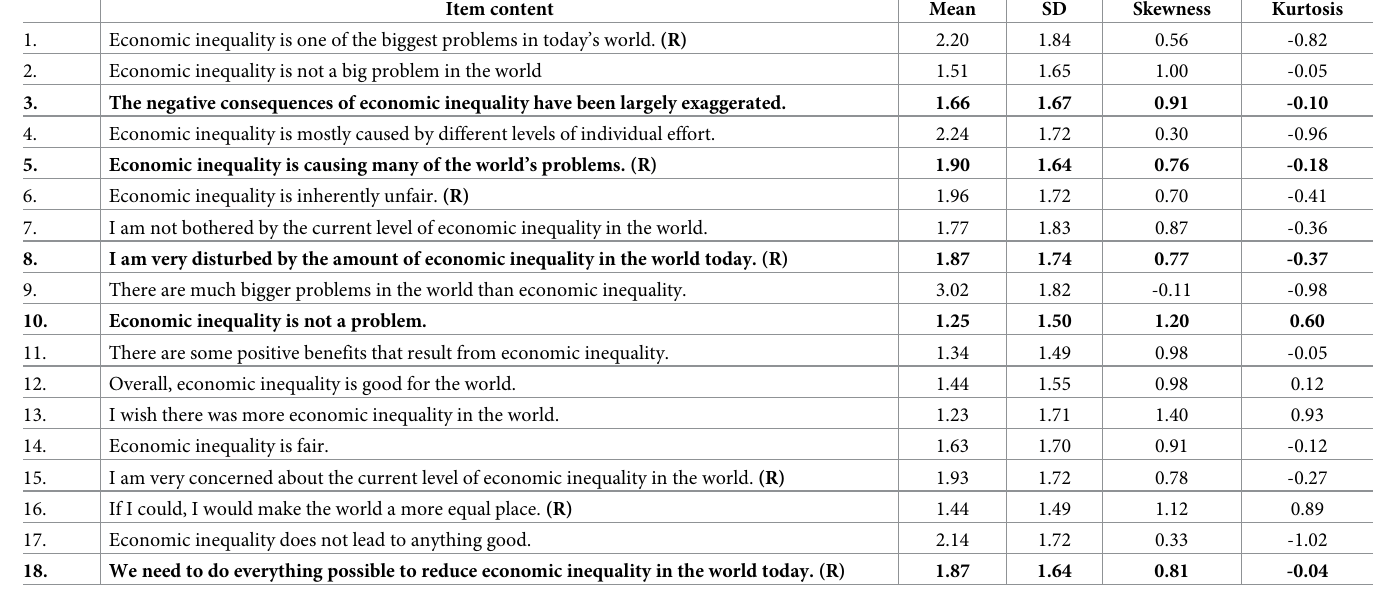
Table 1. Original 18 items, with their descriptive statistics from Study 1. (R) denotes item is reverse coded. Descriptive statistics were calculated after each relevant item was reverse